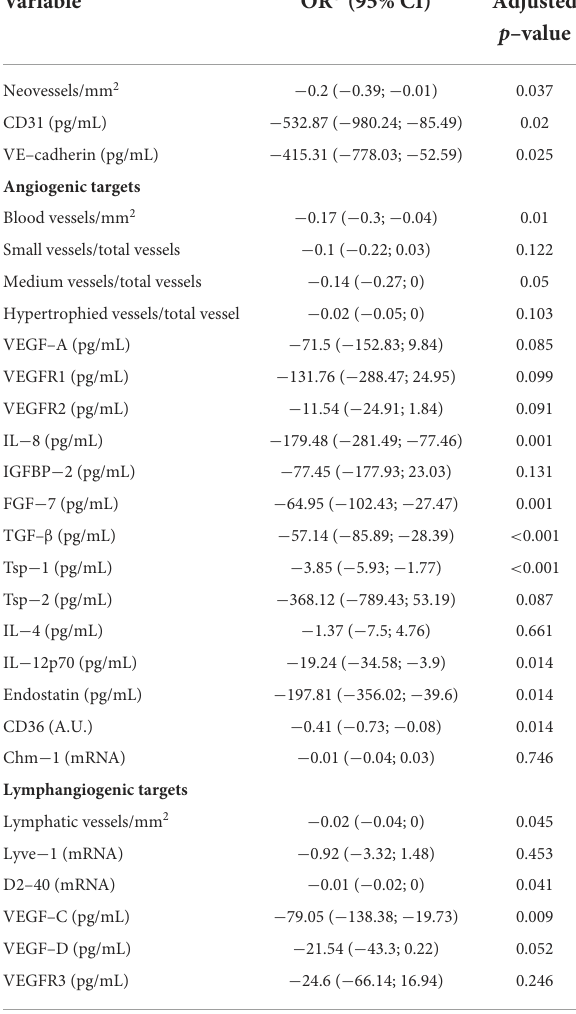
TABLE 2 Multivariate analyses after adjusting for confounder factors in the study